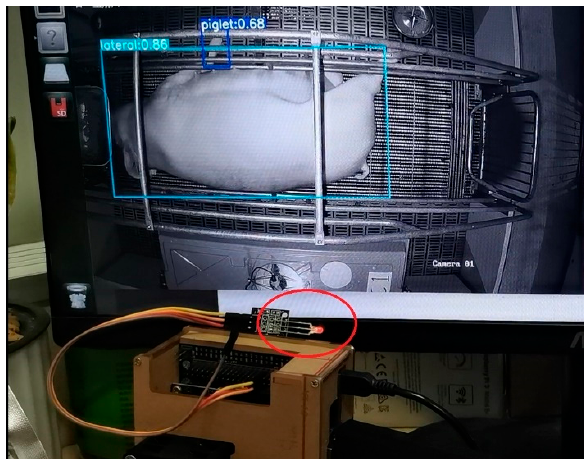
Figure 13. Sow farrowing